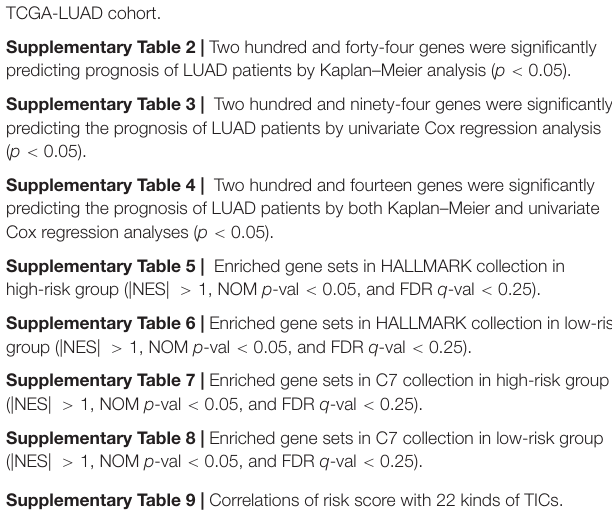
Supplementary Figure 1 | Characteristics of the eight-gene signature. (Upper and middle) The distribution of risk score and patient’s survival time, as well as status for training cohort based on overall survival (A) and validation cohort based on overall survival (B) . The black dotted line is the median cutoff dividing patients into low-risk and high-risk groups. (Bottom) Heatmap of the eight-gene expression profiles in prognostic signature for training cohort based on overall survival (A) and validation cohort based on overall survival (B) . Supplementary Figure 2 | The correlation between the eight-gene signature and tumor mutational burden in LUAD. The blue line in each plot was fitted linear model indicating the proportion tropism of the copy number along with risk score. The shade around the blue line represents the 95% confidence interval. The Spearman coefficient was used for the correlation test. LUAD, lung adenocarcinoma. Supplementary Figure 3 | TIC profile in tumor samples in the training cohort and correlation analysis. (A) Bar plot showing the proportion of 22 kinds of TICs in LUAD tumor samples in the training cohort. The column names of the plot were sample ID. (B) Heatmap showing the correlation between 22 kinds of TICs. The numeric and shade of each small color box indicate the coefficient between two kinds of cells. X shape covered coefficient is not statistically significant. The Pearson coefficient was used for the significance tests. P value < 0.05 is the cutoff. TIC, tumor-infiltrating immune cell; LUAD, lung adenocarcinoma. Supplementary Table 1 | Immune and stromal scores of each sample of the TCGA-LUAD cohort. Supplementary Table 2 | Two hundred and forty-four genes were significantly predicting prognosis of LUAD patients by Kaplan–Meier analysis ( p < 0.05). Supplementary Table 3 | Two hundred and ninety-four genes were significantly predicting the prognosis of LUAD patients by univariate Cox regression analysis ( p < 0.05). Supplementary Table 4 | Two hundred and fourteen genes were significantly predicting the prognosis of LUAD patients by both Kaplan–Meier and univariate Cox regression analyses ( p < 0.05).